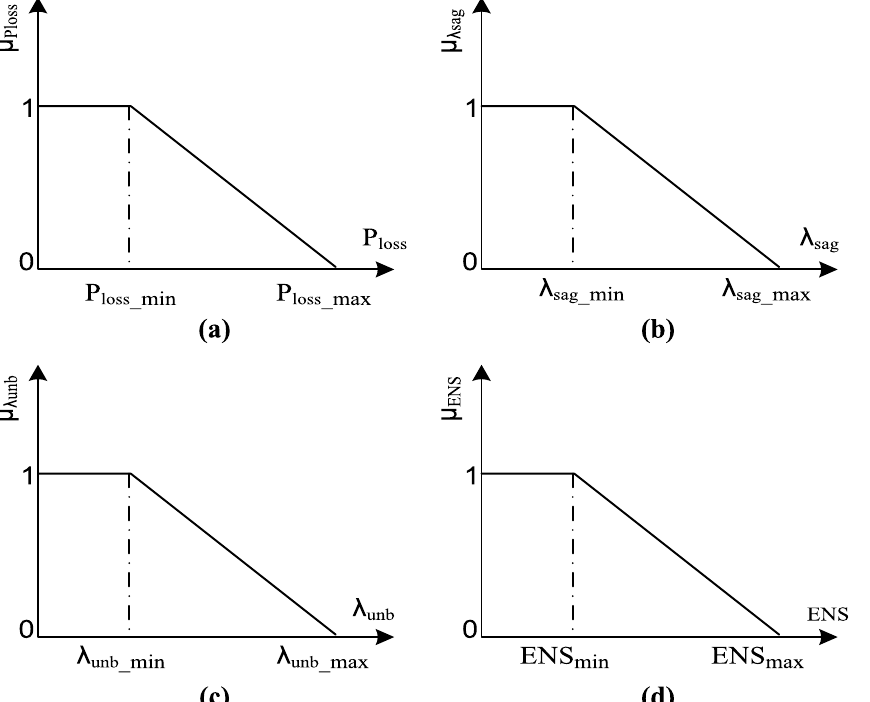
Figure 1. Fuzzy membership function applied for different objective functions ( a ) P loss , ( b ) (cid:31) sag , ( c ) (cid:31) unb , ( d )